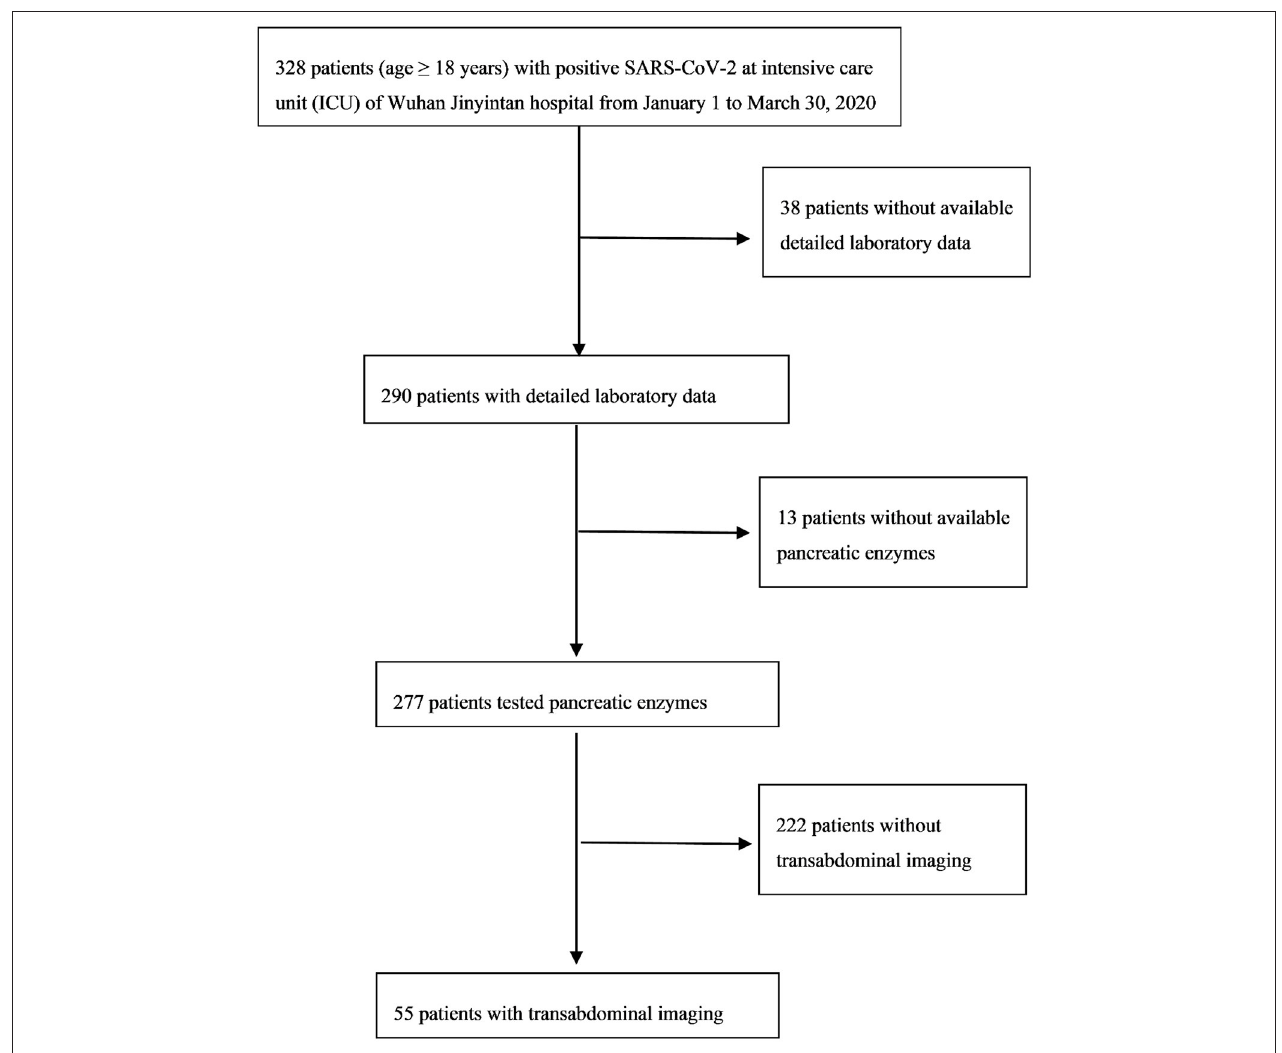
FIGURE 1 | Recruitment